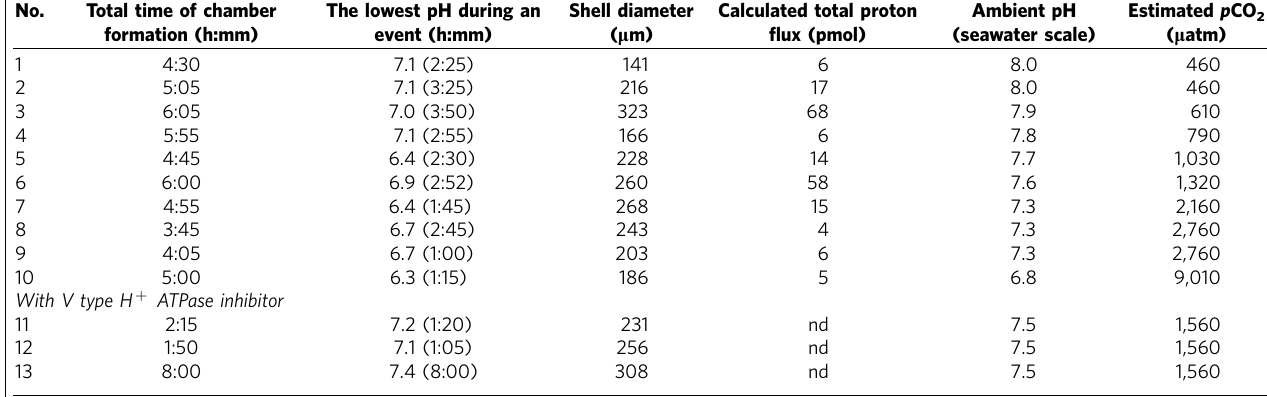
Table 1 | Summary of pH imaging observations during chamber formation. No. Total time of chamber formation (h:mm)